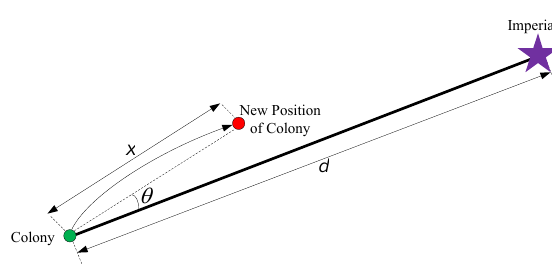
Fig. 3. Movement of colonies toward their relevant imperialist 15 .